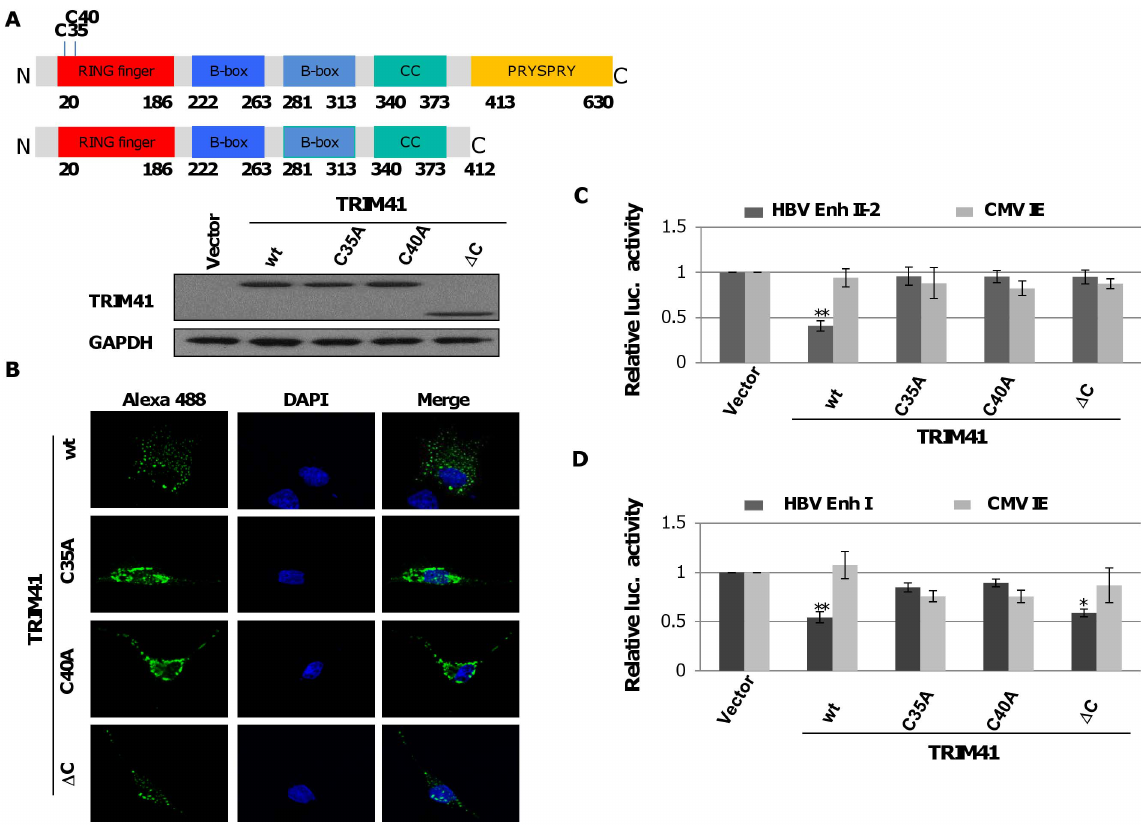
Figure 6. RING finger and PRYSPRY domains of TRIM41 are essential for the inhibition of HBV Enh II activity. 0.4 m g of plasmids expressing wild type or mutant TRIM41 were transfected into HepG2 in 24 well plates. The cells were harvested at two days post transfection. Expression of TRIM41 was determined by Western blot assays (A) or immunofluorescence (B). (C) 0.2 m g of pGL4.10-HBV Enh II was co-transfected into HepG2 cells in 24 well plates with 0.2 m g of a vector plasmid or plasmid expressing the wild type or indicated mutant TRIM41, with 0.1 m g of pCMV- renilla luciferase as an internal control. Two days post transfection, cells were harvested and the luciferase activity was analyzed with a dual-luciferase kit. The mean and standard deviations (n=4) were presented. * and ** indicate P , 0.05 and 0.01, respectively.